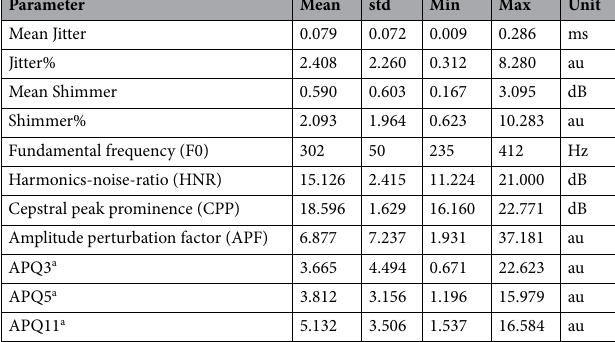
Table 3. Audio parameters. a Amplitude perturbation quotient with varying windows sizes.